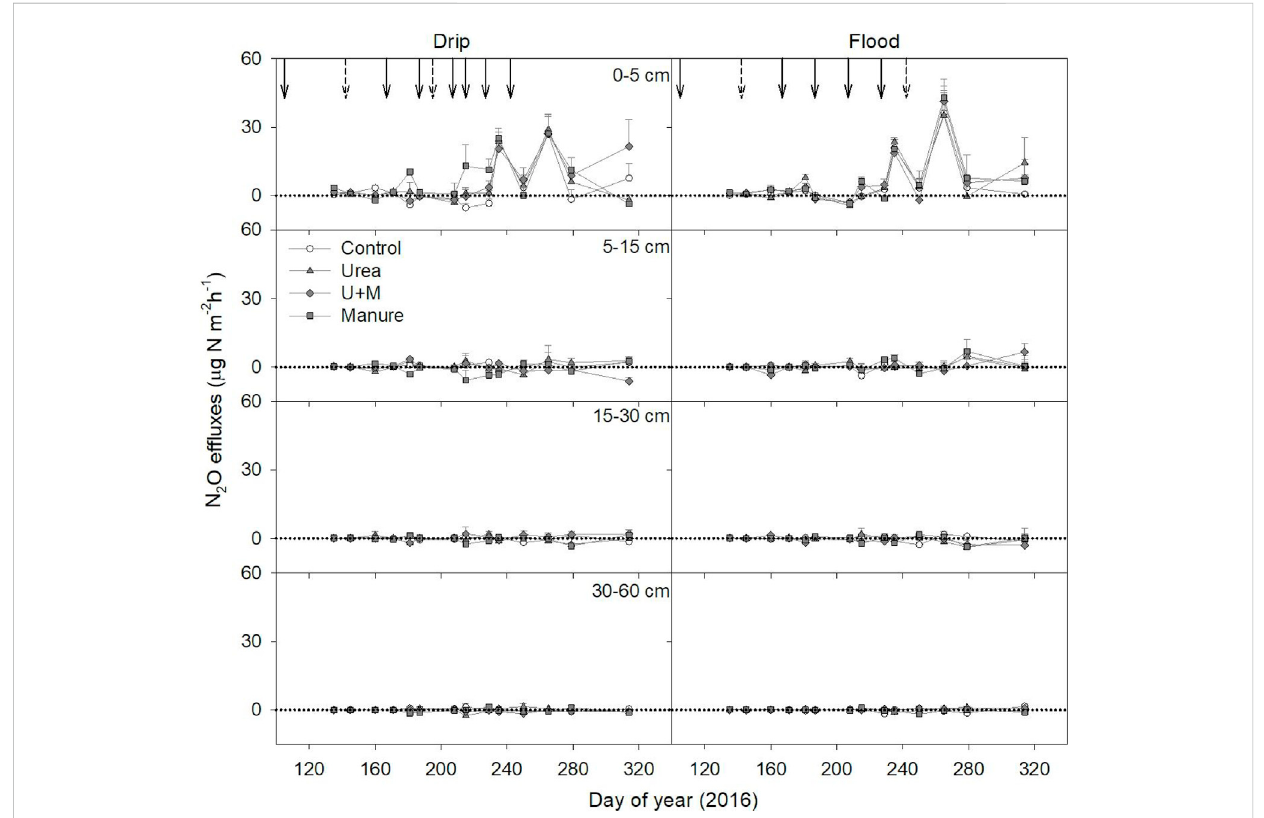
FIGURE 3 The N 2 O ef fl uxesateachsoil layer as affectedby fertilizer treatments underdrip and fl oodirrigation. Dashed arrows indicate datesof irrigation only, and solid arrow indicates date of irrigation and fertigation of urea applications. Means +1 standard error ( n = 4) are